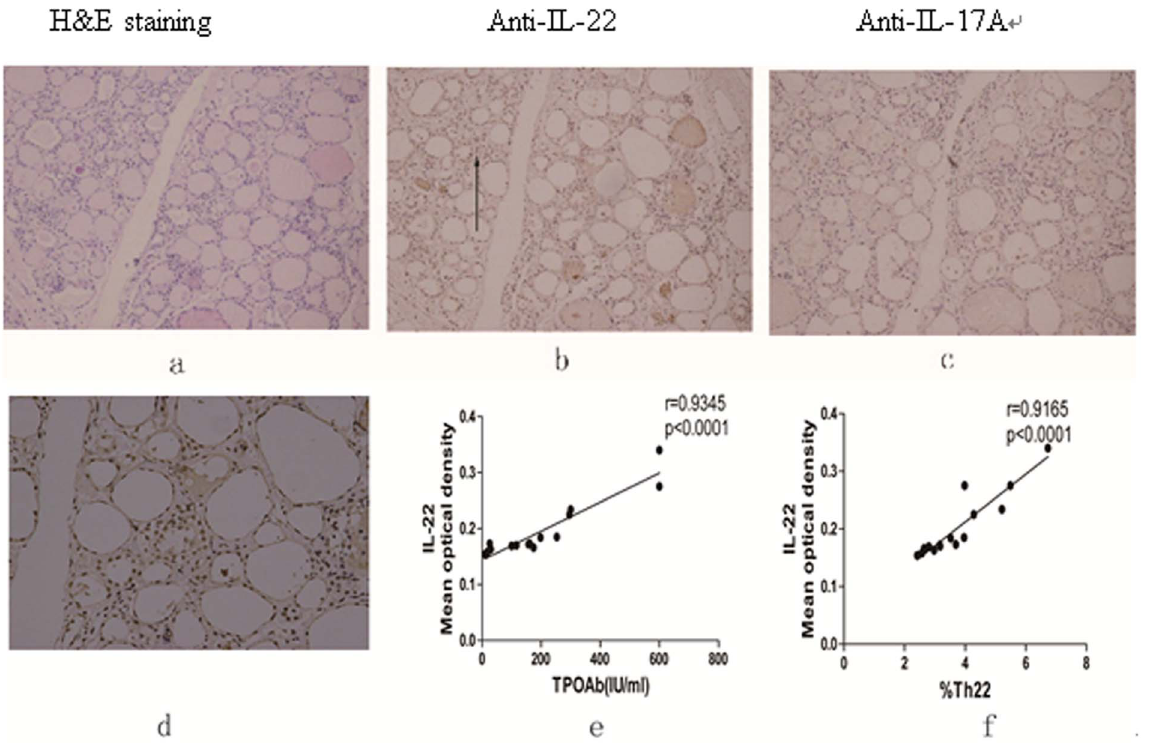
Figure 5. Immunohistochemistry analysis of IL-17A and IL-22 in the thyroid tissues of newly diagnosed HT patients. The thyroid tissue samples were obtained from 15 patients, who were subjected to a surgical resection of the thyroid nodules and the thyroid tissue sections were characterized by H&E staining and immunohistochemistry analysis of IL-17A and IL-22 expression. The mean optical density (MOD) of immunostaining was quantified. The potential correlation of MOD values for anti-IL-22 staining with the levels of serum TPOAb and the percentages of Th22 cells in the HT patients was analyzed. Data shown are representative images and expressed as the mean values of individual patients. A. HE staining of the thyroid tissue section (magnification 6 200); B. Immunohistochemical detection of IL-22 in the thyroid tissues of a HT patient (magnification 6 200). C. Immunohistochemical detection of IL-17A (magnification 6 200). D. Immunohistochemical staining of anti-IL-22 (magnification 6 400). Correlation analyses of IL-22 mean optical density with E. TPOAb and F.